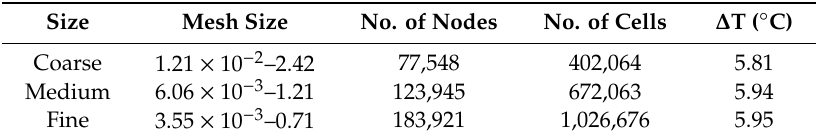
Table 2. Mesh independence